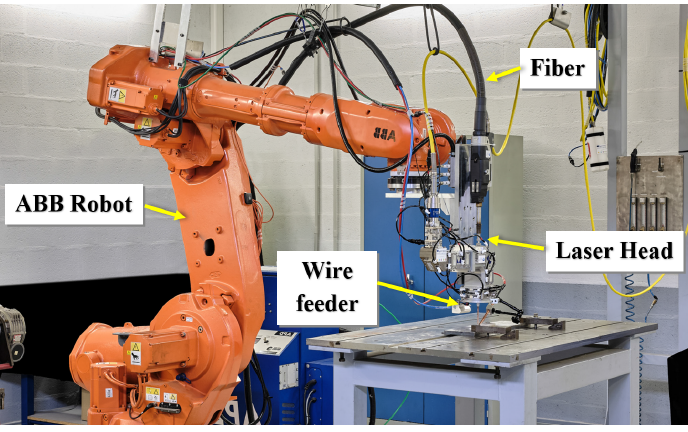
Figure 6. Experimental Setup of LWAM platform at Institut de Soudure.